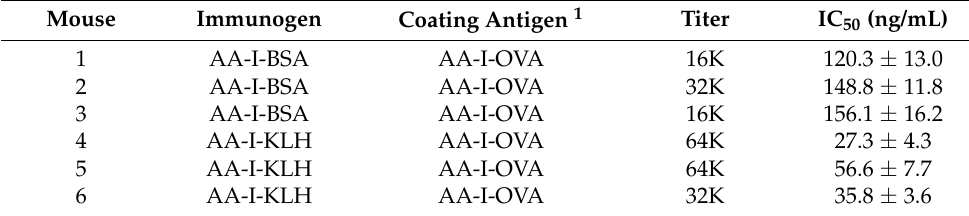
Figure 1. The strategic schema of mAb production. AA ‐ I: aristolochic acid I; EDC: 1 ‐ (3 ‐ dimethylaminopropyl) ‐ 3 ‐ ethylcar ‐ bodiimide hydrochloride; NHS: N ‐ hydroxysuccinimide; KLH: keyhole limpet haemocyanin; OVA: ovalbumin. Table 1. Characterization of mouse antiserum against AA ‐ I ( n = 3).